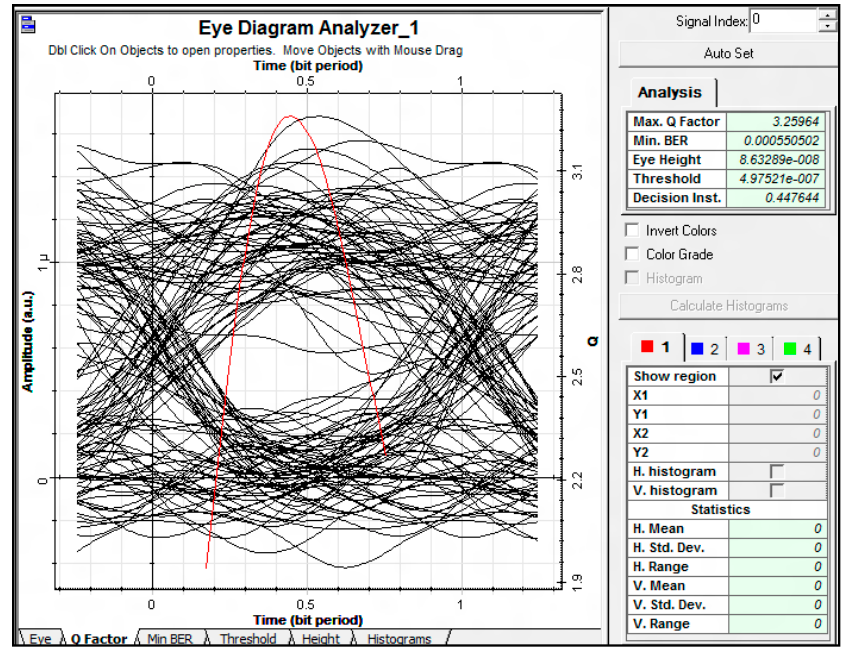
Figure 4. Eye diagram for one user of SAC-OCDMA system using EDW code and PIN photodetector at 622 Mbps and 100 km.